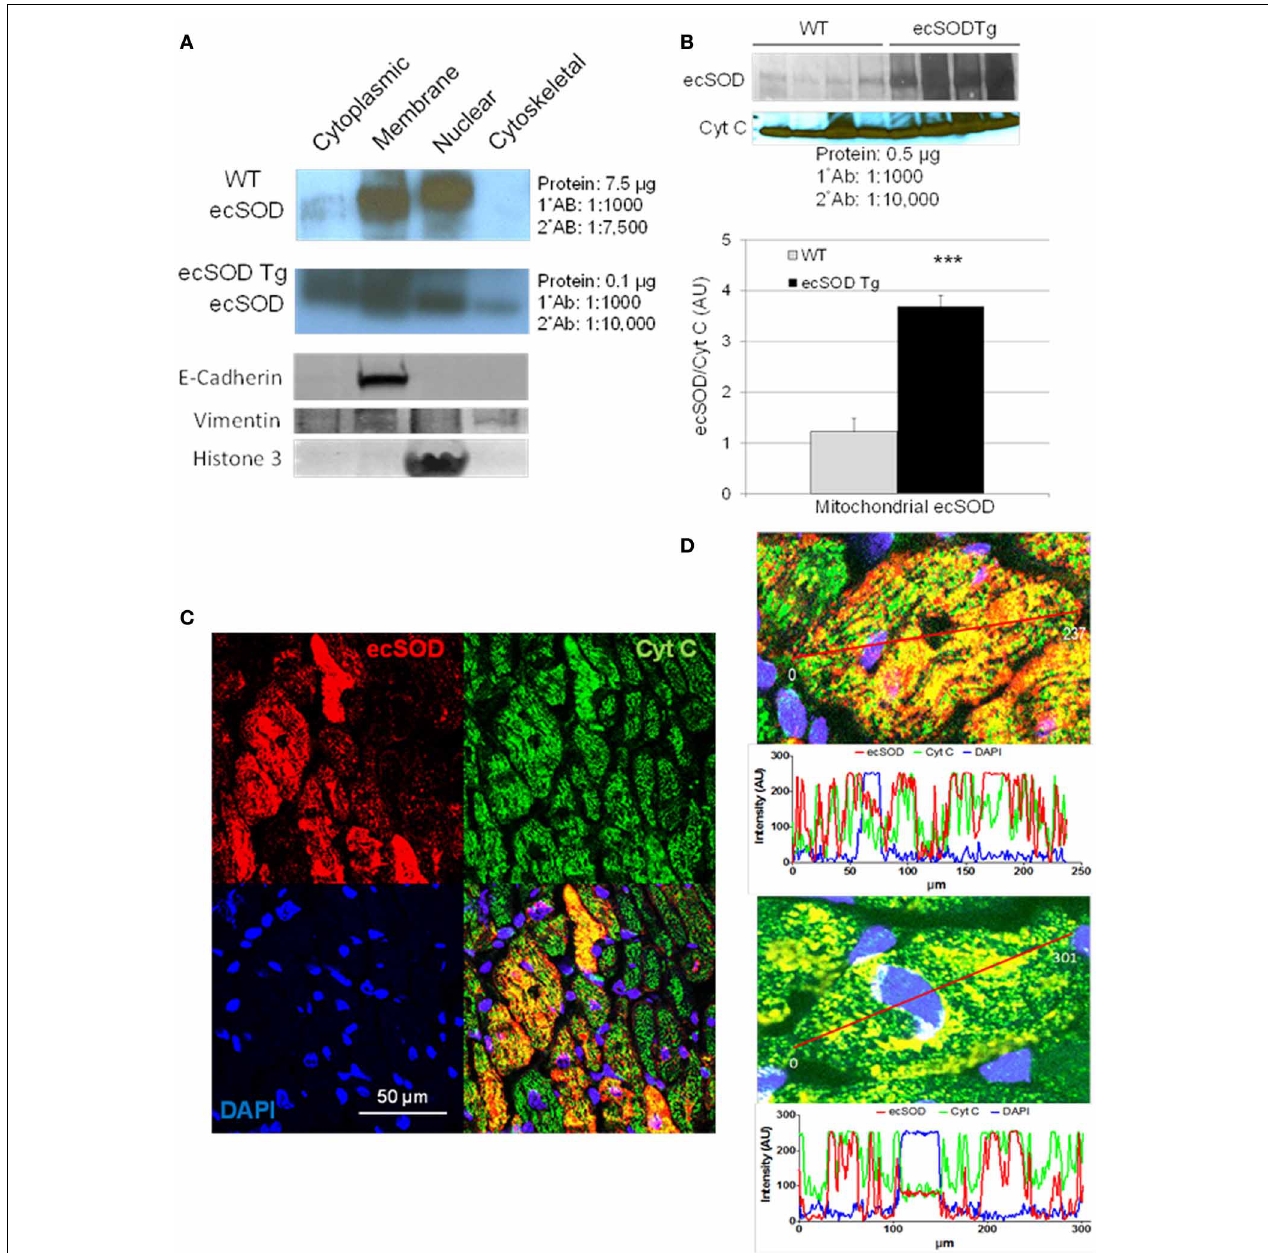
FIGURE 2 | ecSOD is expressed in intracellular compartments. ecSOD expression was determined in membrane, cytosolic, cytoskeletal, and nuclear fractions from WT and ecSOD Tg myocytes (A) . ecSOD was further colocalized to mitochondria isolated from WT and ecSOD Tg hearts by Western analysis (B) . ecSOD colocalization